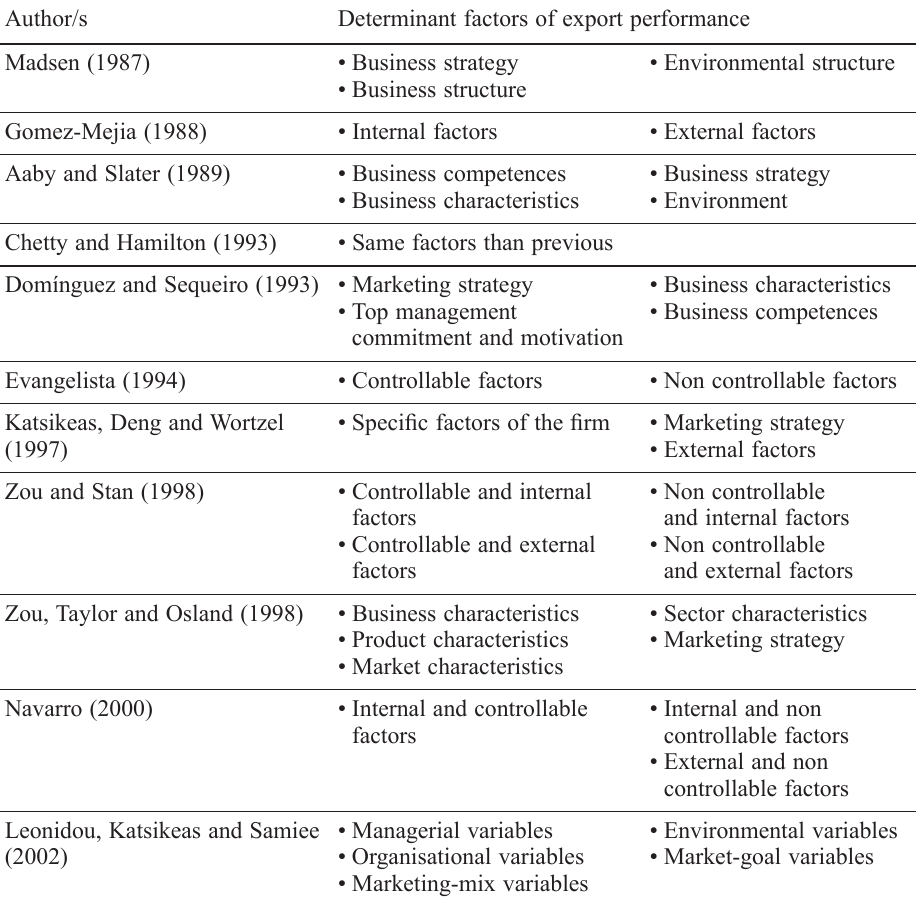
Table 1. Determinants of export performance of the fi